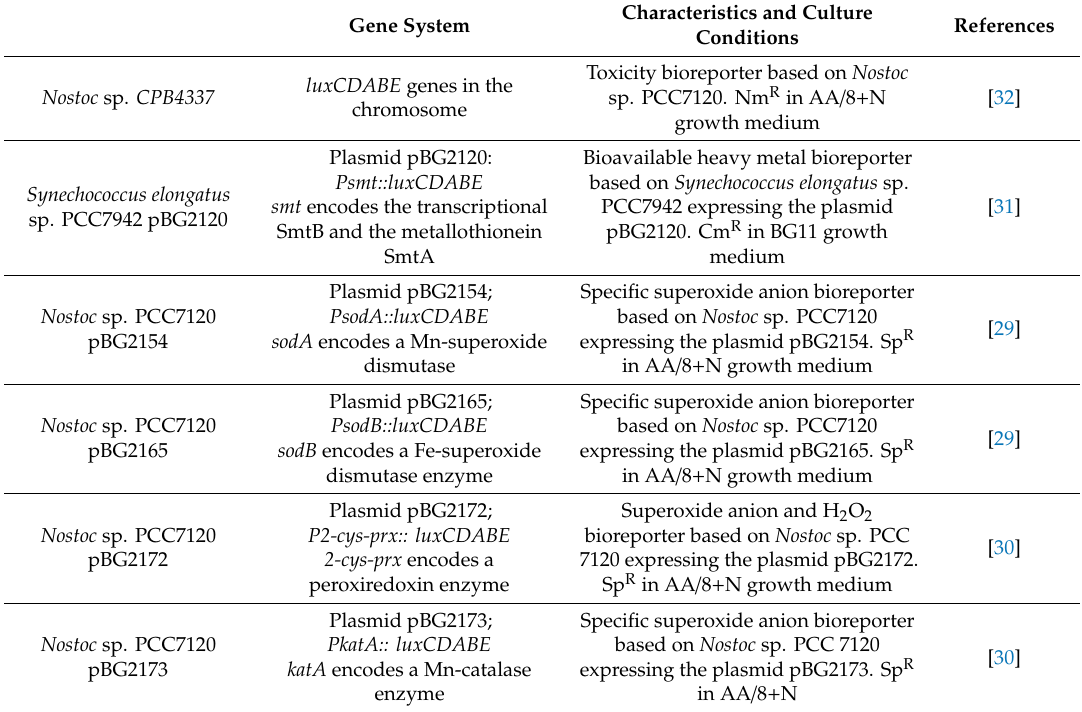
Table 1. Cyanobacterial strains used in this study and their culture conditions. All the reporter luxCDABE genes are from Photorhabdus luminescens